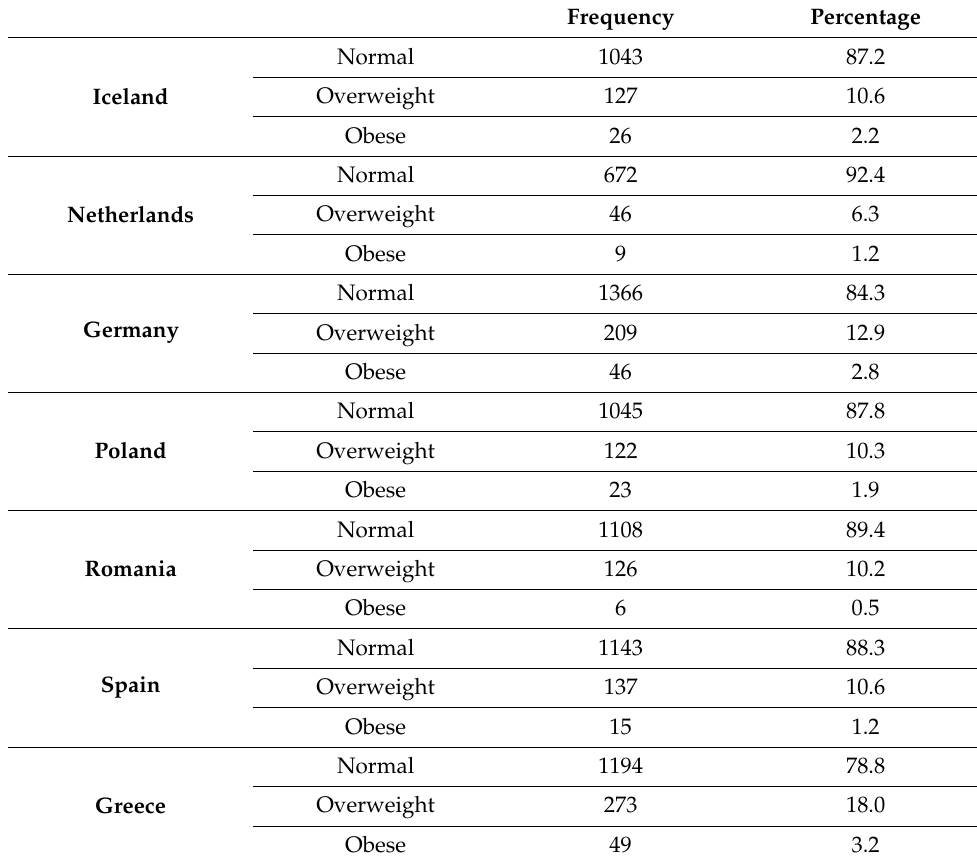
Table 1. Description of the study sample ( n = 8785). Frequency of normal weight, overweight and obese adolescents in the seven countries participating in the European Network for Addictive Behavior (EU NET ADB)